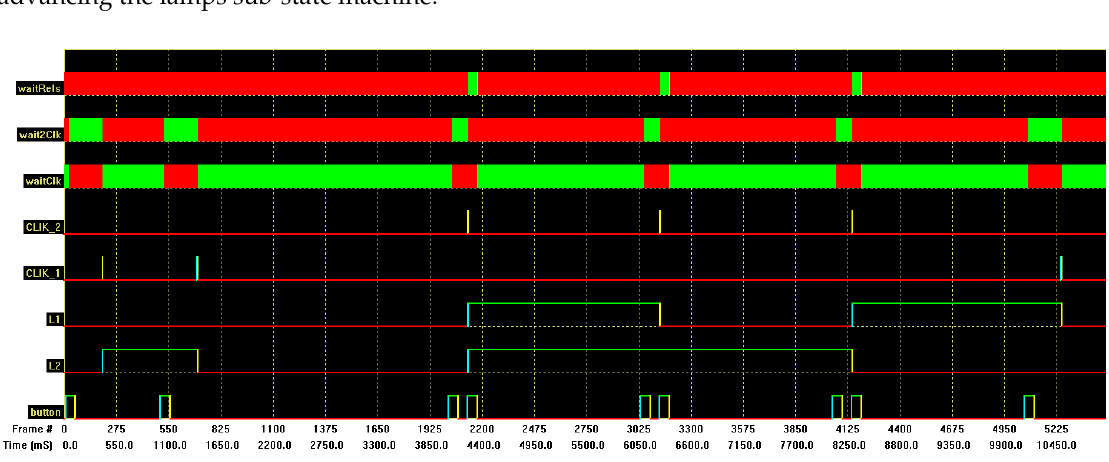
Figure 20. Temporal visualization of simulation results.